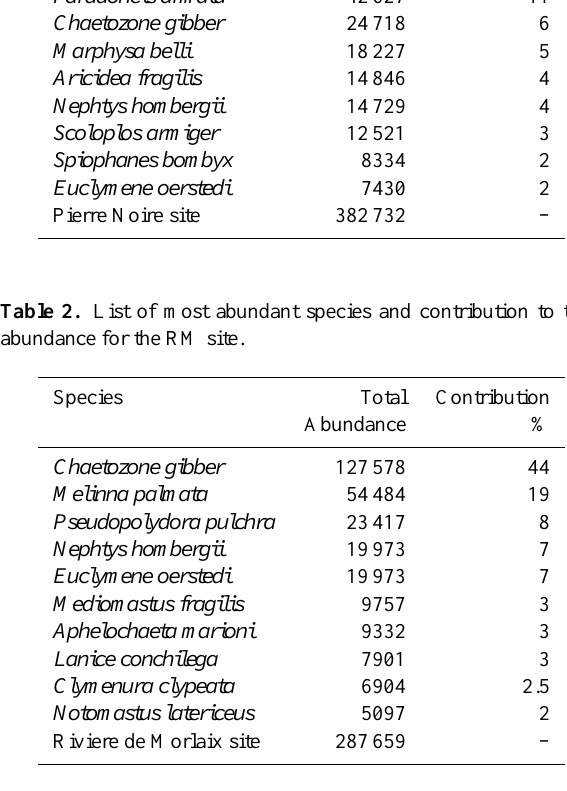
Table 3. List of most abundant Spionid species and contribution to total spionid abundance for the PN site.